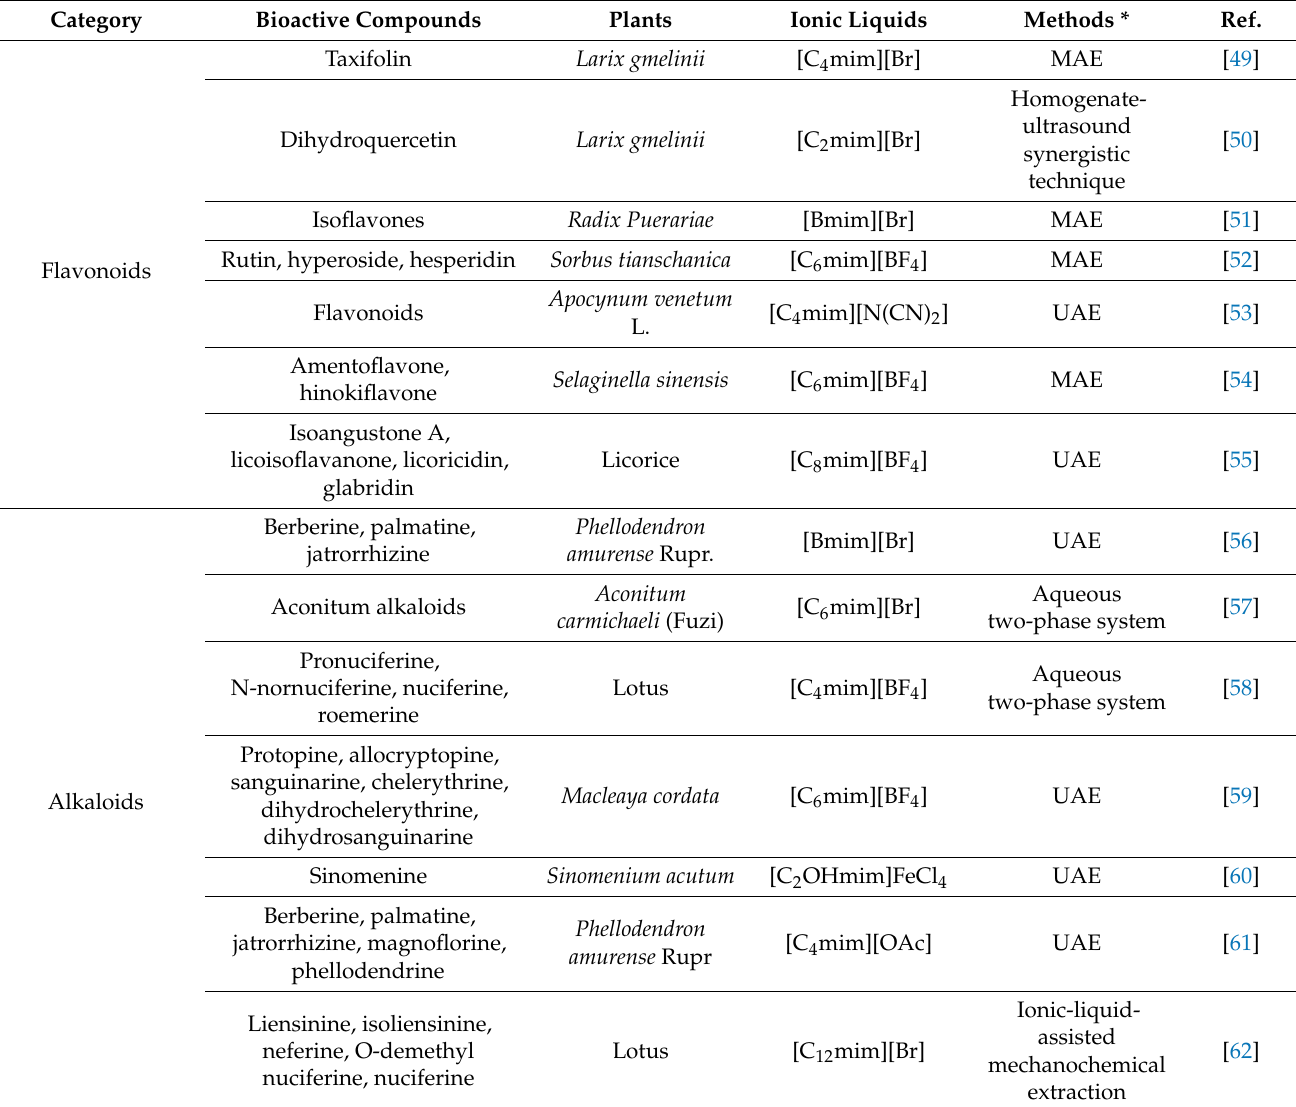
Table 3. Extraction of phytochemicals by imidazolium ionic